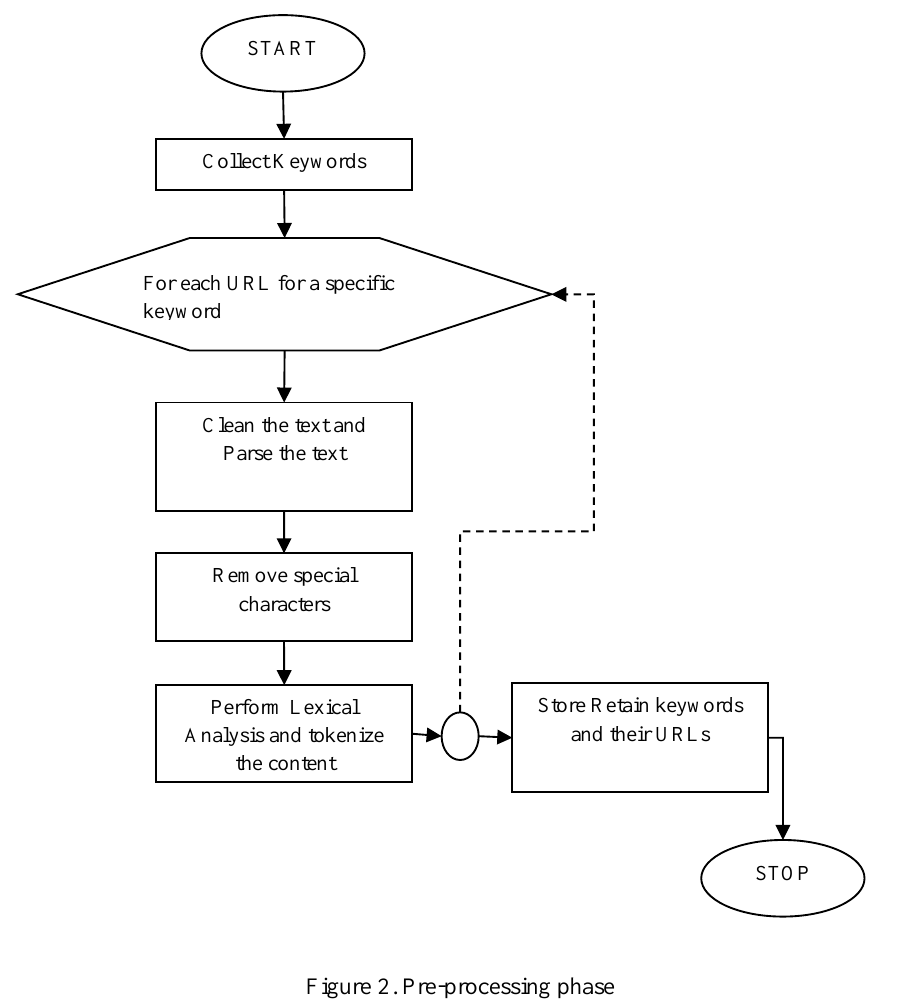
Figure 2. Pre-processing